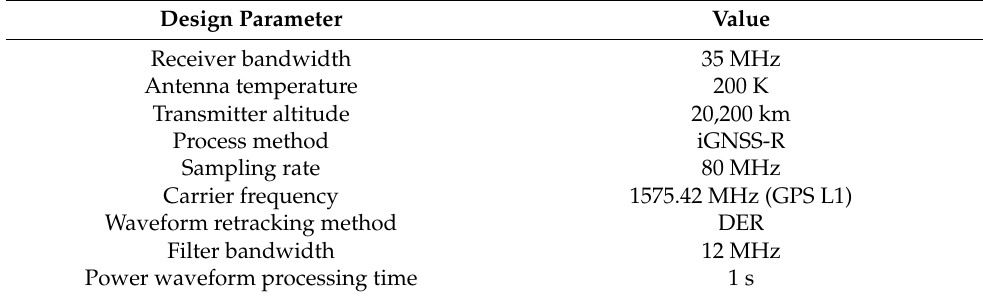
Table 2. The common simulation parameters for spaceborne altimetry scenarios.